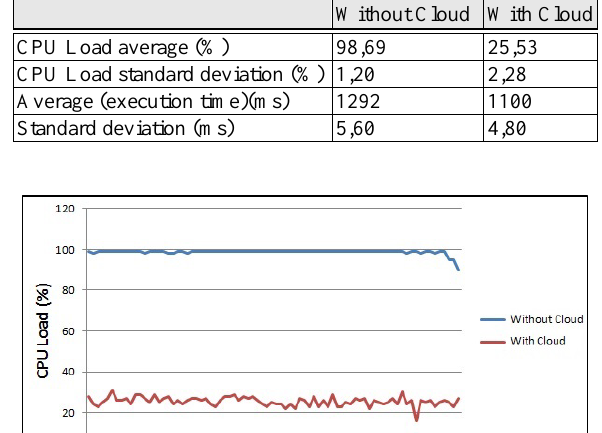
Table 5. Time delays for face detection and